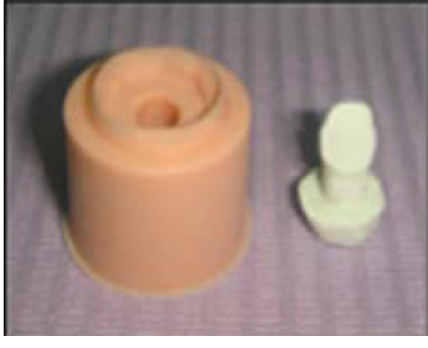
Figure 5: Poured stone die.